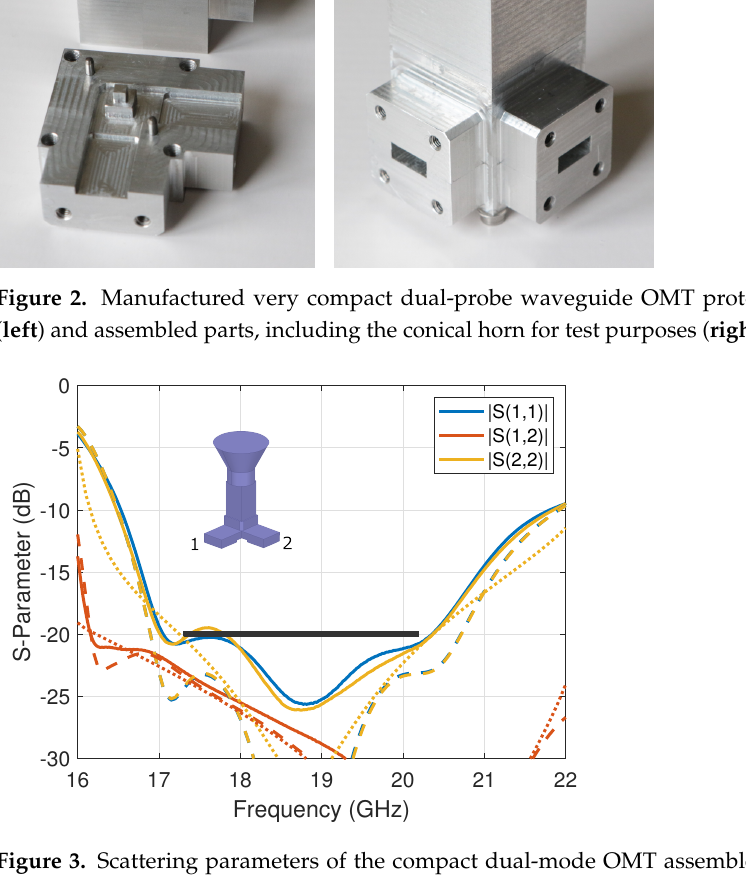
Figure 3. Scattering parameters of the compact dual-mode OMT assembled with a conical horn, comparing measured ( solid lines ) and simulated ( dashed lines ) results. The simulated standalone OMT results are overlaid in dotted lines . The specifications are marked with a black thick line